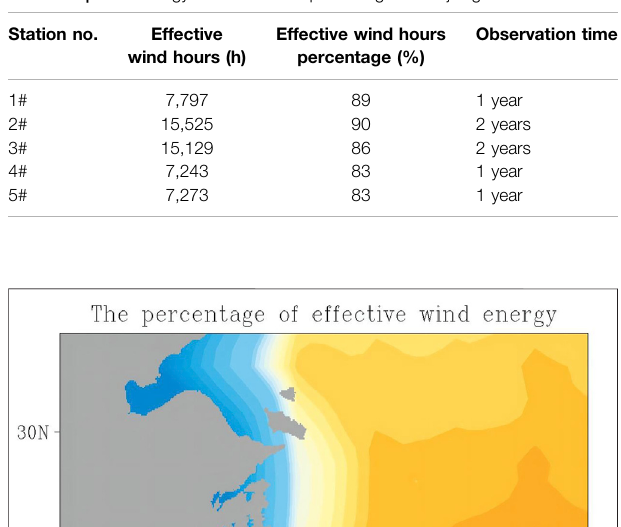
TABLE 2 | Wind energy effective hours percentage of Zhejiang coastal.